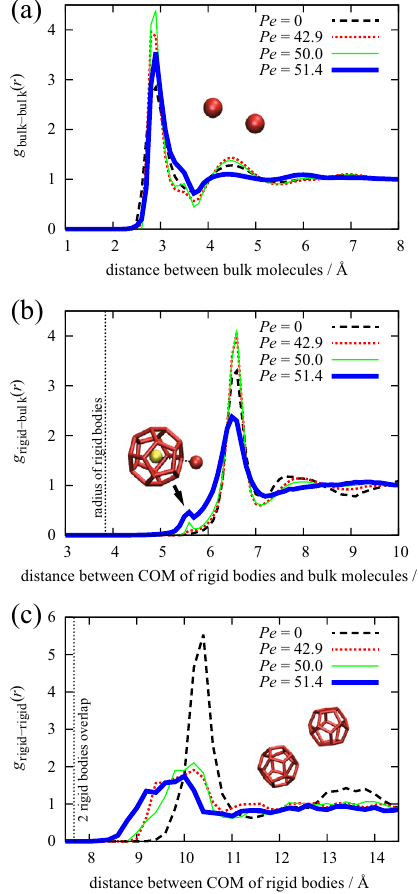
Figure 2. Radial distribution functions of 20 rigid bodies immersed in 2600 particles between ( a ) particle and particle, ( b ) COM (yellow particle shown in the inset) of the rigid body and particles, and ( c ) COM of the rigid bodies and COM of the rigid bodies for each Pe = 42.9 (at Newtonian region), 50 (at critical Pe ), and 51.4 (at shear-thickening